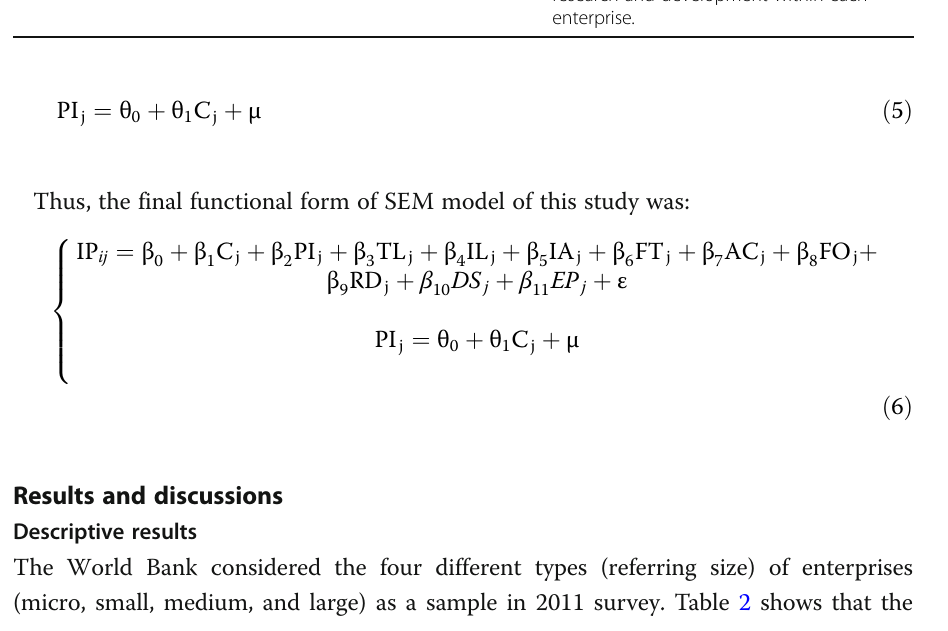
Table 2 Type of enterprises in the different scale Type of